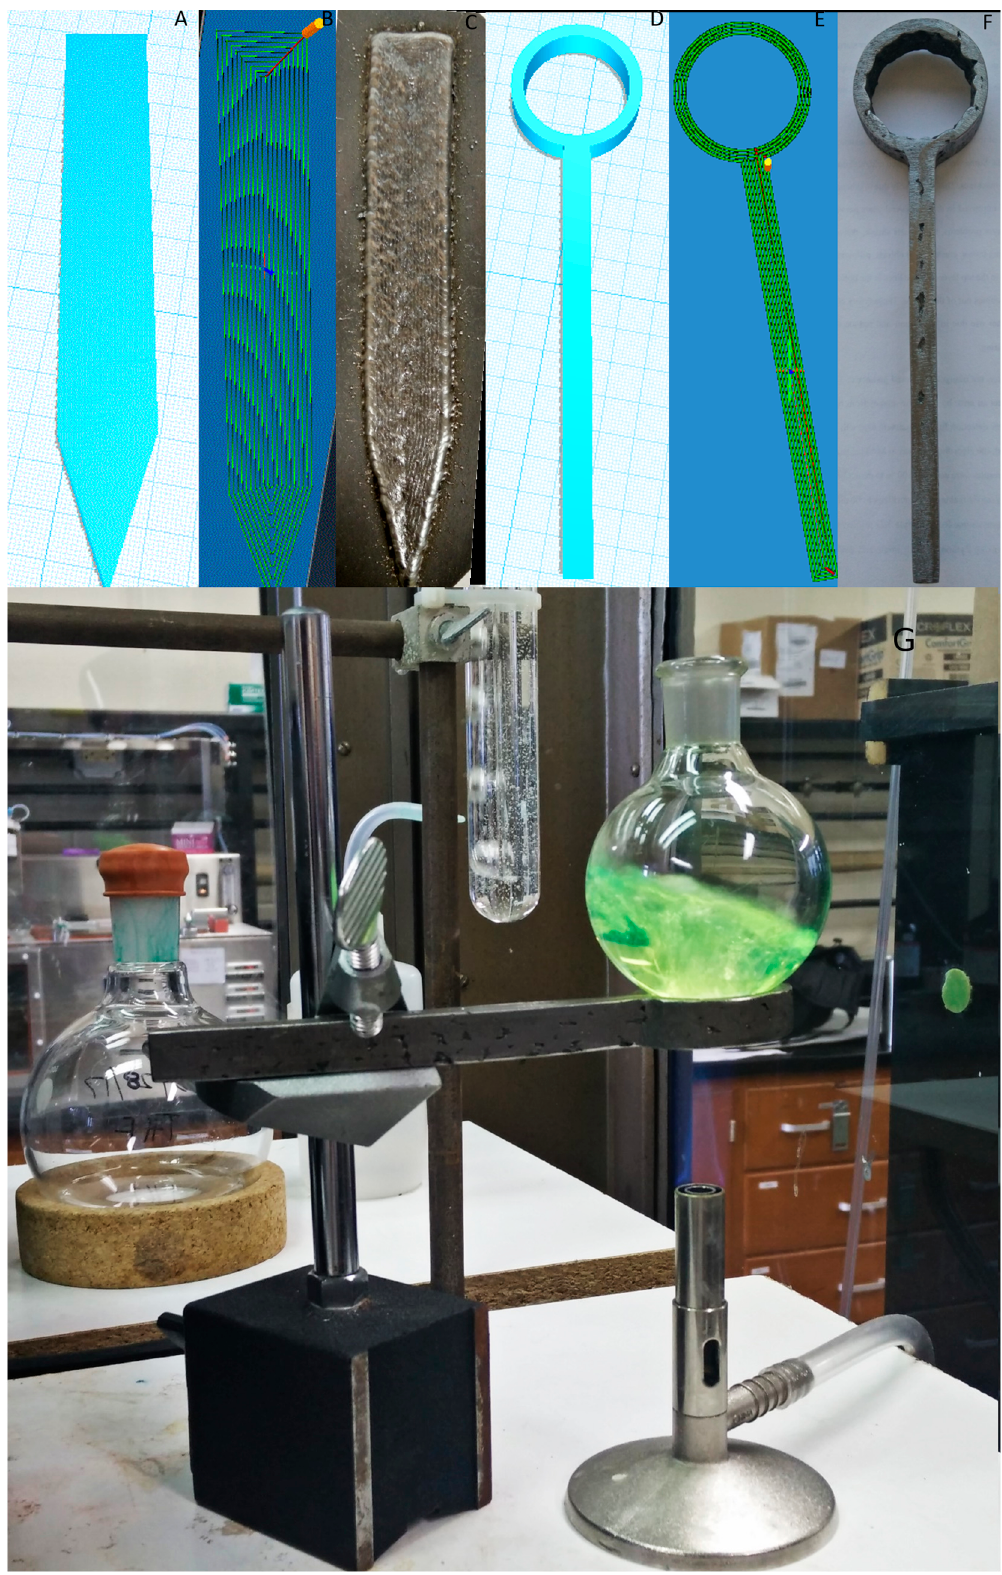
Figure 3. ( A ) 3-D model; ( B ) toolpath; ( C ) metal 3-D printed part on substrate; ( D ) 3-D model; ( E ) toolpath; ( F ) metal 3-D printed part; and ( G ) ring support used in a chemistry laboratory.